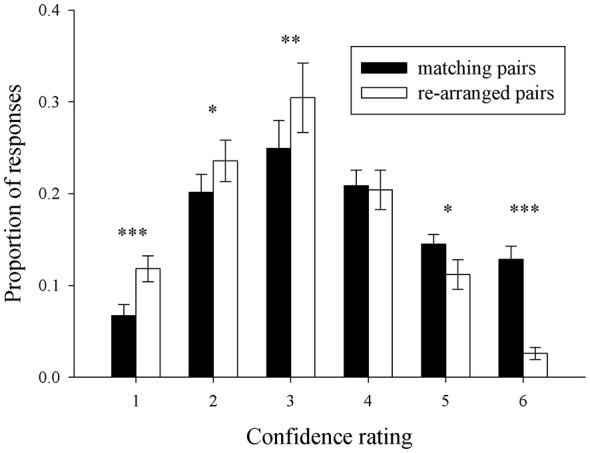
Behavioral performance on the subsequent recognition memory (LTM) task. Distributions of mean hit and false alarm rates: Mean (±SEM) proportions of responses are depicted on the y-axis and confidence ratings (“1”: definitely a re-arranged pair; “6”: definitely a matching pair) on the x-axis. ***p < 0.001, **p < 0.01, *p < 0.05.